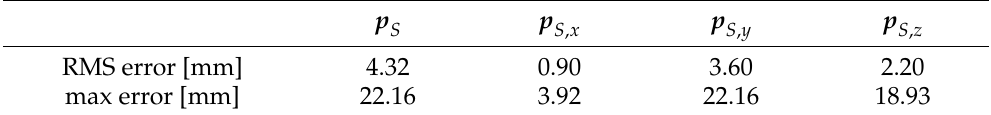
Figure 11. Spray frame tracking with respect to the optimal reference trajectory generated by the MPC algorithm. p * represents the optimal trajectory of the spray frame. This differs from the S ideal lawnmower trajectory due to MPC tuning that sacrifices reference tracking to minimize the accelerations of the mobile base and the manipulator end-effector. z R and z R represent the upper and lower foliage boundaries, respectively. The spray frame position p during the experiment is S represented by a red line. Table 2. Spray frame position errors during the vineyard spraying